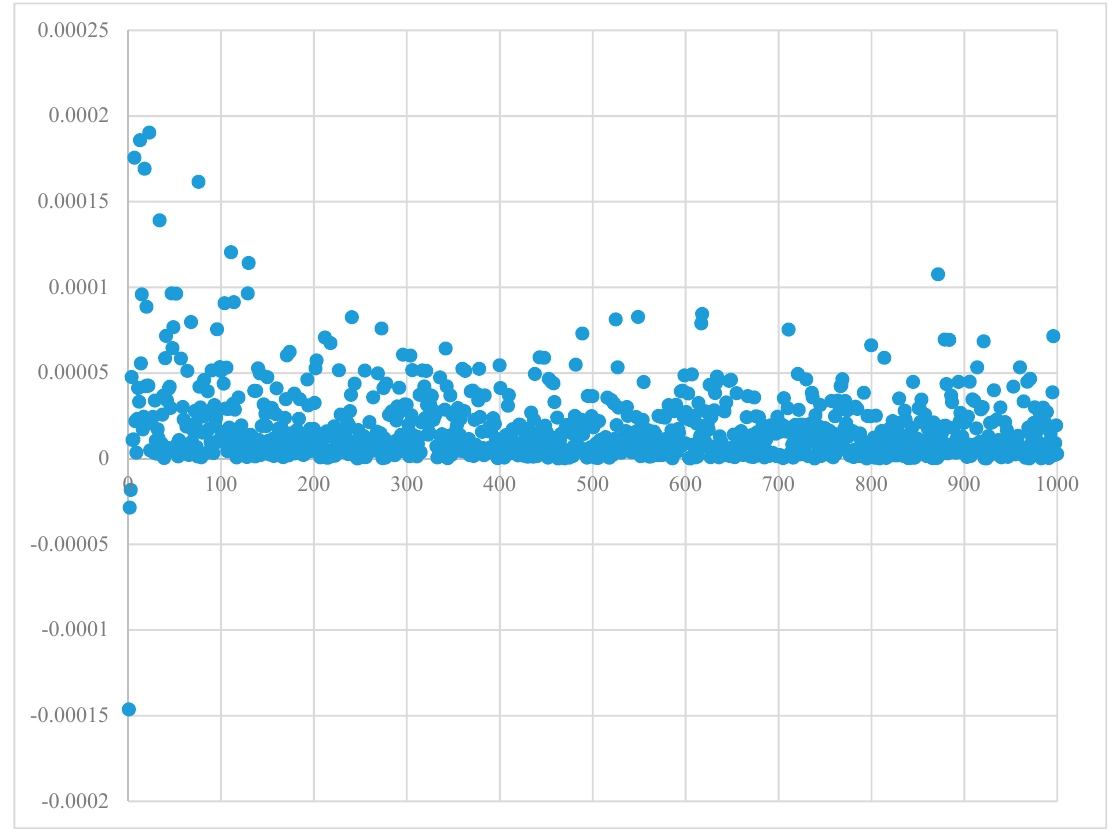
Figure 7. Error term diagram, difference between forecasted changes with duration and actual NPV changes.